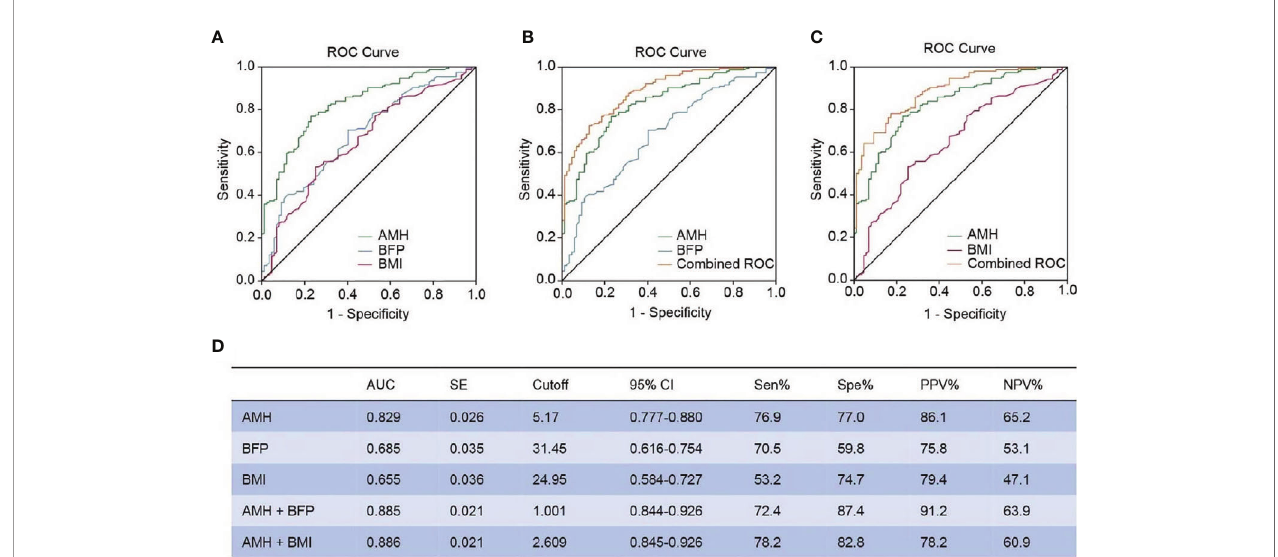
FIGURE 3 | ROC analysis between AMH, BFP, and BMI. (A) Diagnostic potential of AMH, BFP, and BMI for PCOS estimated using ROC analysis. (B) Combined curve of AMH with BFP. (C) Combined curve of AMH with BMI. (D) AUC, SE, cutoff value, 95% CI, Sen%, Spe%, PPV%, and NPV% of ROC curves. ROC, receiver operating characteristic; AUC, area under the curve; SE, standard error; CI, con fi dence interval; Sen%, sensitivity %; Spe%, speci fi city %; PPV, positive predictive value; NPV, negative predictive